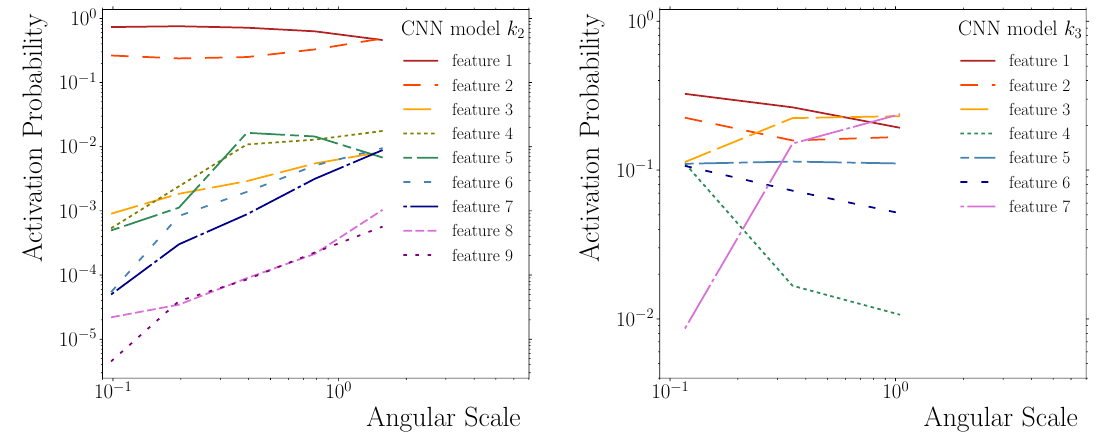
Figure 11 . Evolution of the feature activation rates with angular scale for model k 2 (left) and model k 3